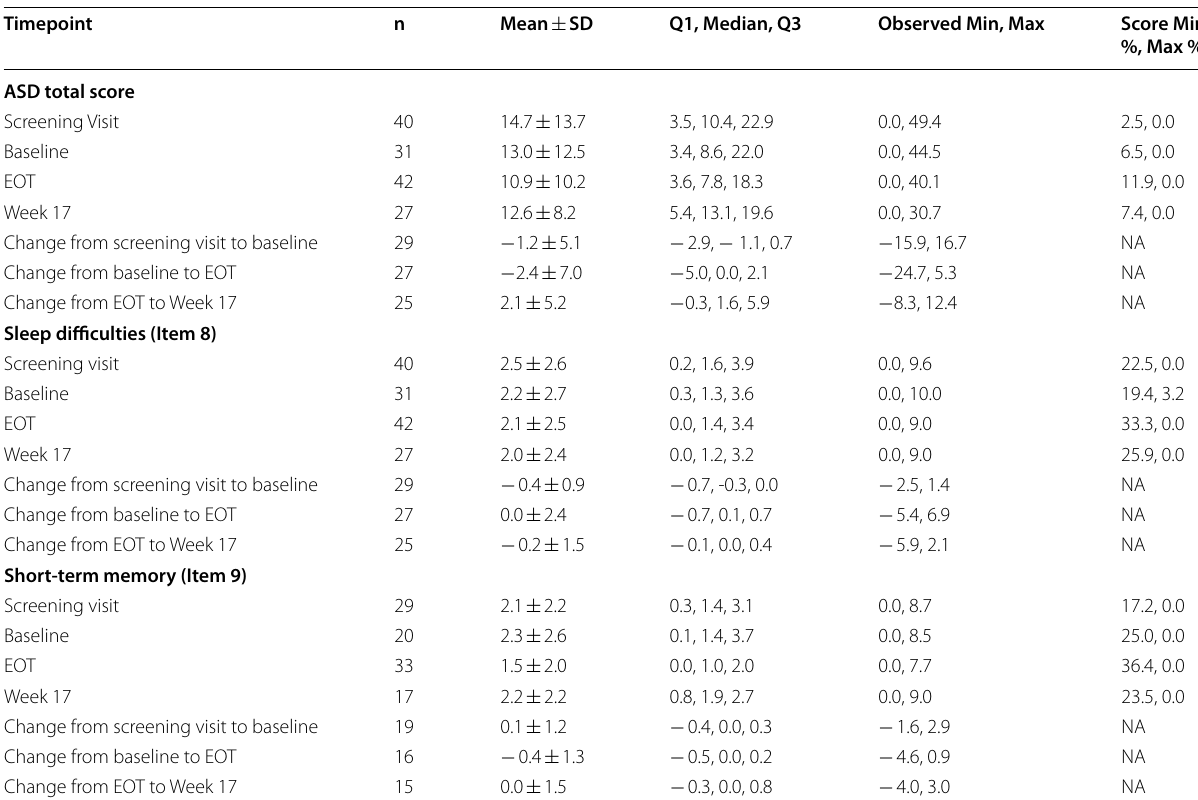
Table 4 ASD Total Score, Item 8, and Item 9 across study